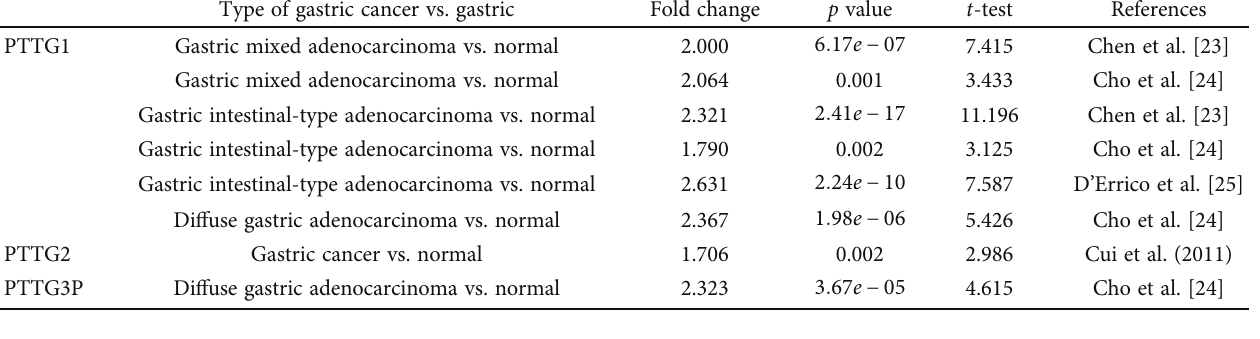
Table 1: Gastric cancer and healthy gastric tissues exhibit striking di ff erences in the transcription level of the PTTG family (Oncomine). Type of gastric cancer vs.